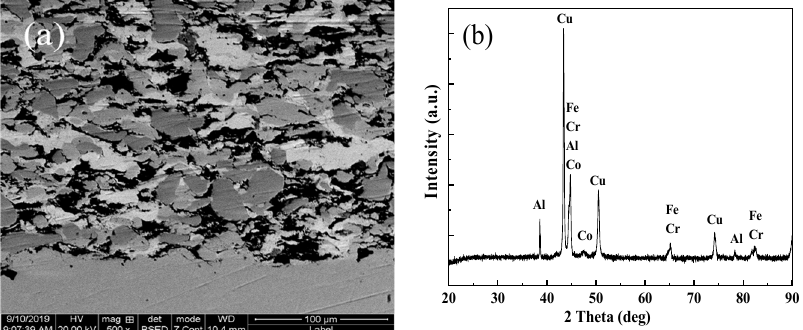
Figure 3. SEM image and XRD pattern of the cold-sprayed coating: ( a ) mixed-metal coating cross section and ( b ) XRD pattern.